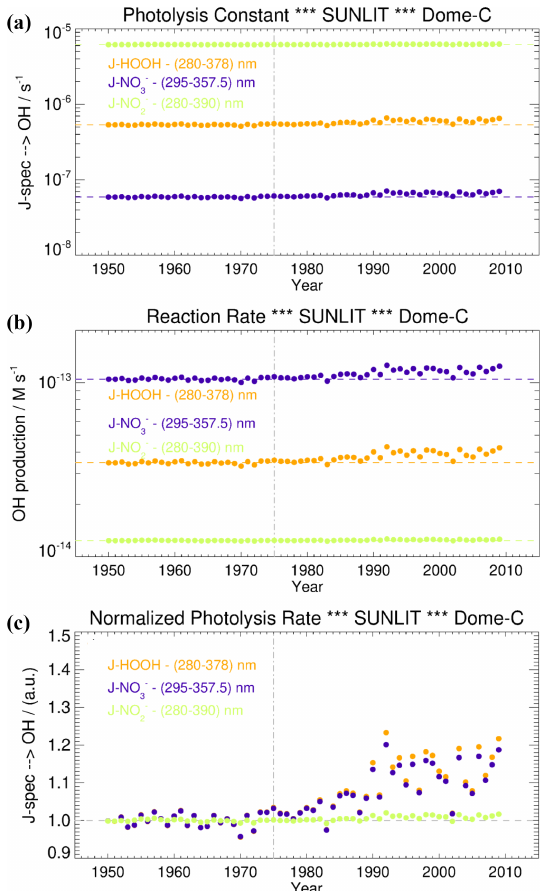
Figure 4. (a) The photolysis constant of hydrogen peroxide (orange line), nitrate (violet), and nitrite (green) over the period 1950–2009. (cid:113) (b) The OH production rate after the hydrogen peroxide photol- ysis (orange), nitrate (violet), and nitrite (green) over the period 1950–2009. (c) Normalised photolysis rate for hydrogen peroxide photolysis (orange line), nitrate (violet line), and nitrite (green line) over the period 1950–2009. The dashed grey vertical line (1975) represents the beginning of the ozone hole period. The horizon- tal coloured lines represent the average magnitude during the pre- ozone hole period